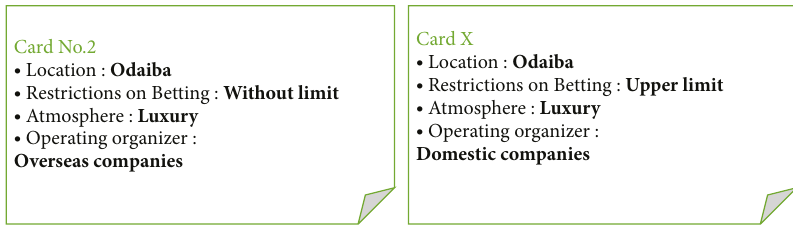
Figure 7: Comparison between two cards with high rating